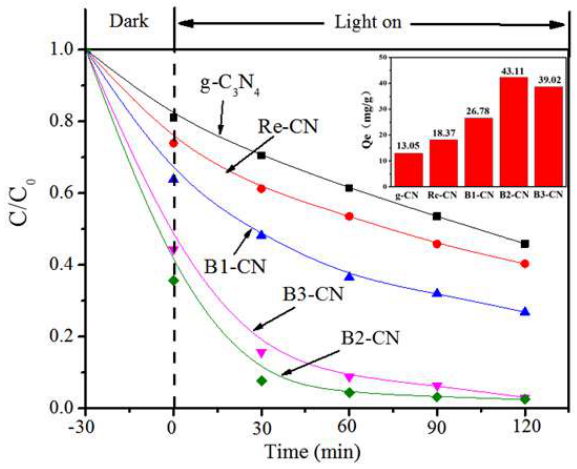
Figure 12. Removal efficiency and adsorption capacity (insert) of MB for all samples.